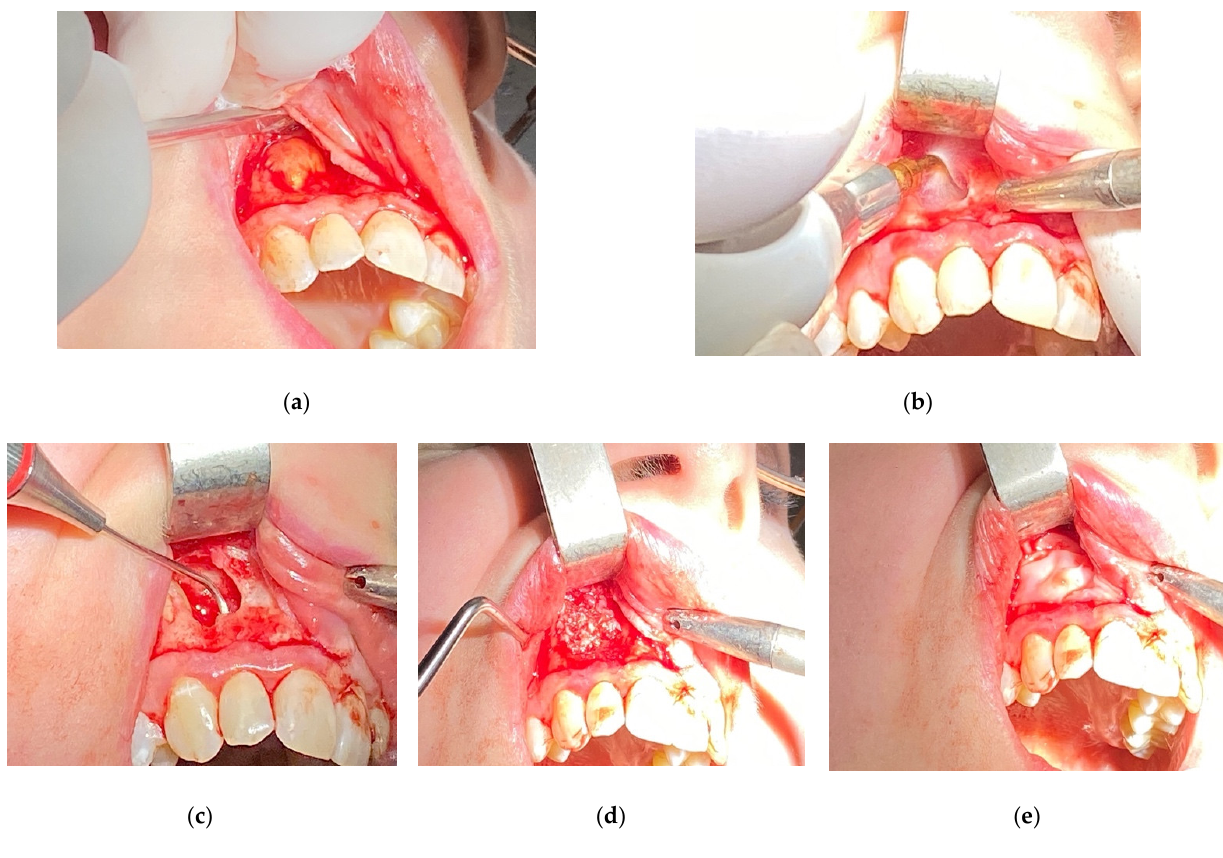
Figure 1. EMS case presentation ( a – e ): ( a ) exposure of the periapical lesion following elevation of the mucoperiosteal flap; ( b ) effective debridement of the bone defect with the use of Piezosurgery ® (Mectron); ( c ) filling the root-end cavity with the use of MAP system ® (Produits Dentaires SA); ( d ) filling of the defect with bone substitute graft; ( e ) resorbable membrane covering the